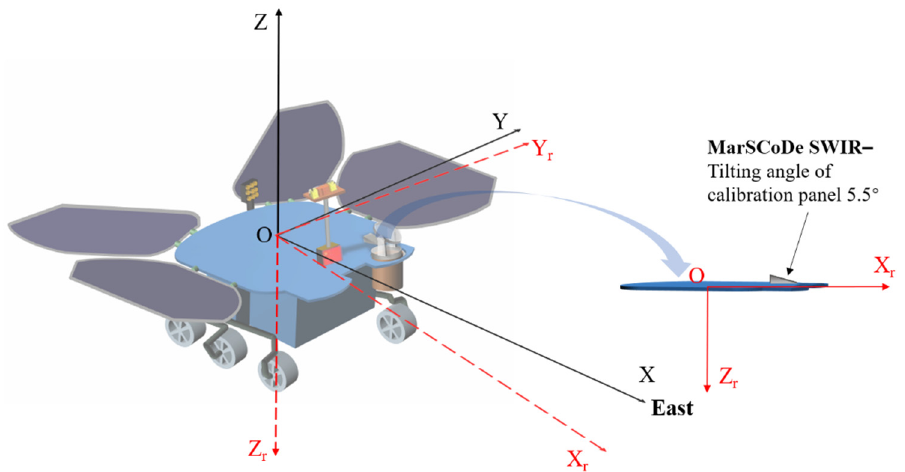
Figure 2. The Mars rover coordinate system. ( left ) Both coordinate systems share a common origin O. The black axis O-XYZ indicates the local cartesian coordinates of the coordinate system, and the red O-Xr Yr Zr indicates the body coordinate system. ( right ) The 5.5° inclination of the calibration panel on the roof of the Mars rover in the body coordinate system.